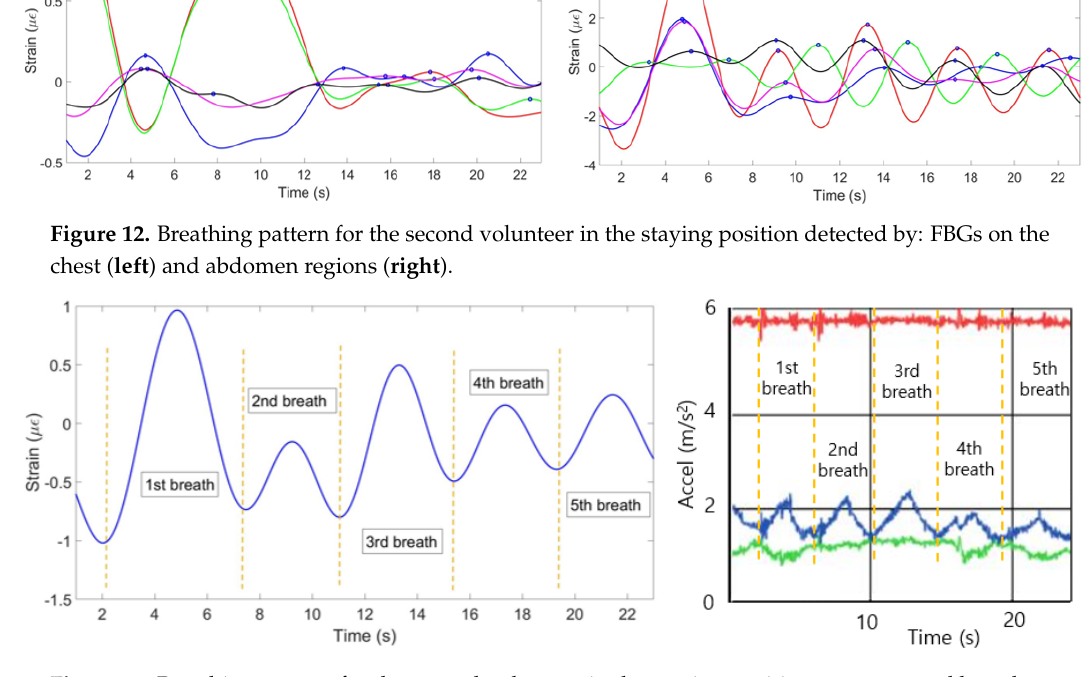
Figure 13. Breathing pattern for the second volunteer in the staying position reconstructed based on the 10 FBGs strain patterns ( left ) and obtained from the reference sensor ( right ).